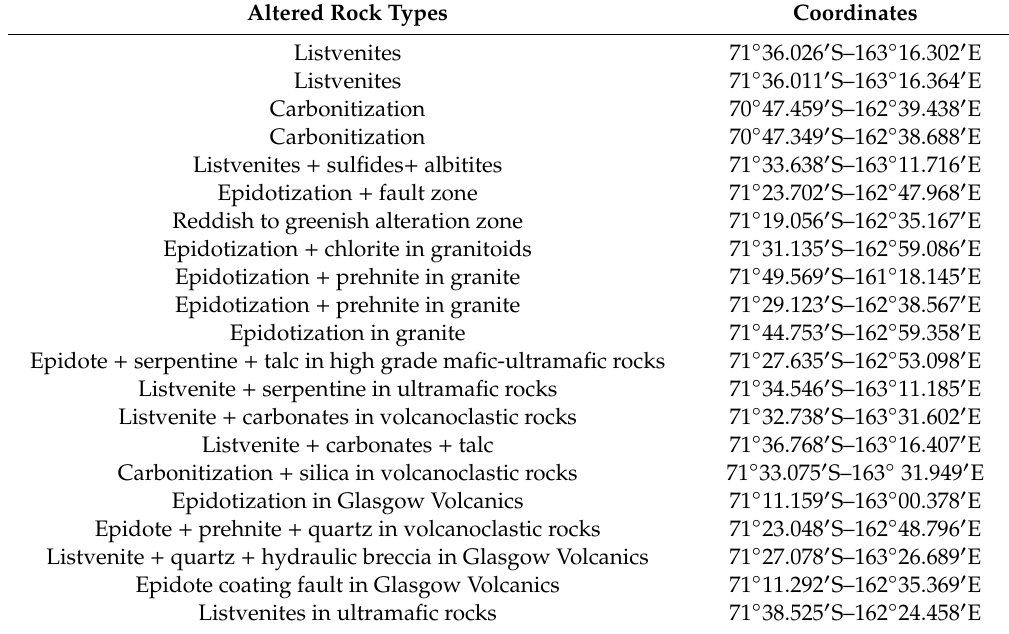
Table A3. Locations of alteration zones and listvenites recorded by Global Positioning System (GPS) readings.